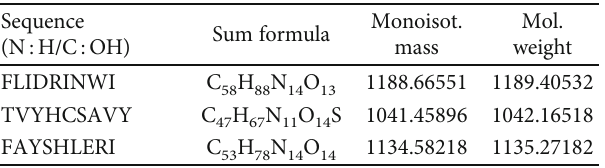
Figure 5: Molecular docking of FLIDRINWI peptide of Nipah virus docked in HLA-A ∗ 02:01 and visualized by UCSF Chimera X version 0.1.0. Table 6: Monoisotopic mass, sum formula, and molecular weight of the three highly proposed peptides.